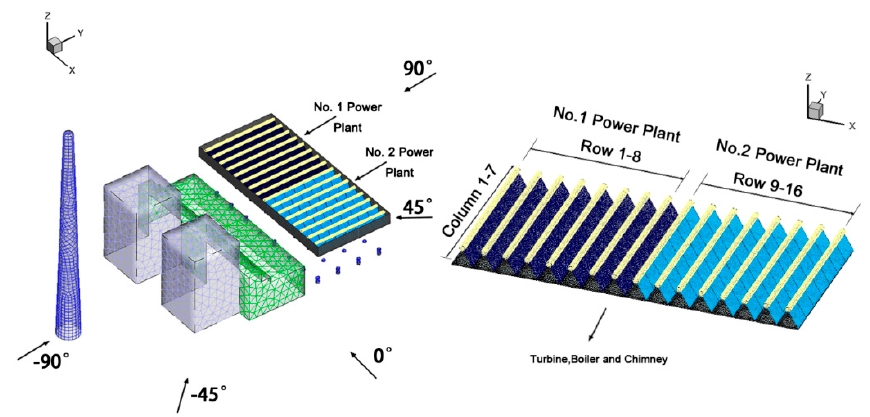
Figure 1. Schematics of the objective air-cooled power generating units and the arrangement ACC of ACC cells.